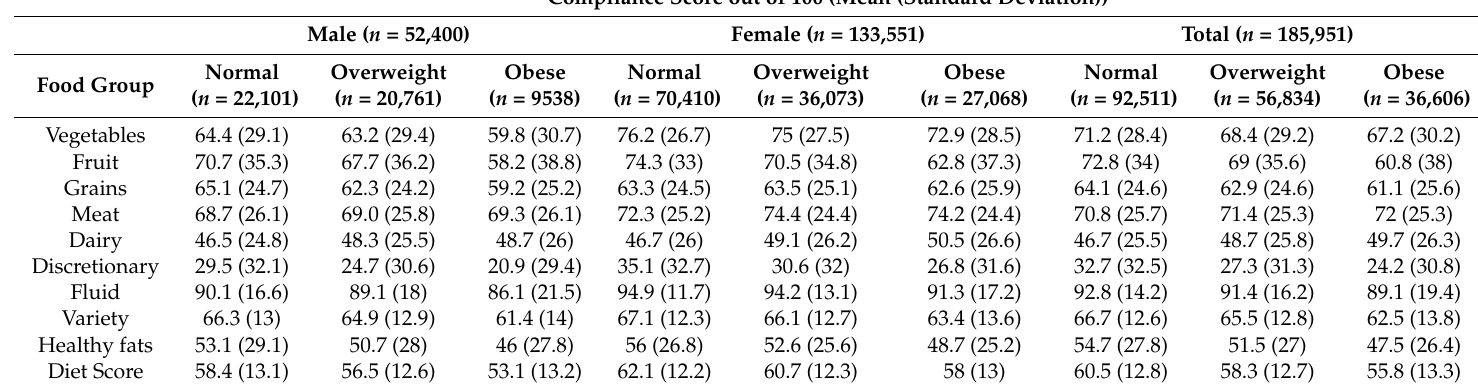
Table 1. Dietary Guideline compliance scores (out of 100) 1 by gender and weight status.